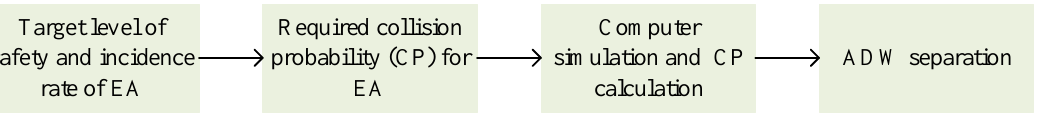
Figure 3. Schematic diagram of ADW